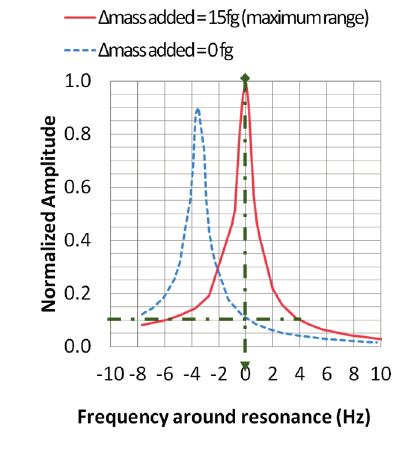
Figure 5. ( a ) Amplitude versus frequency: determination of the operating range; ( b ) Definition of hybrid